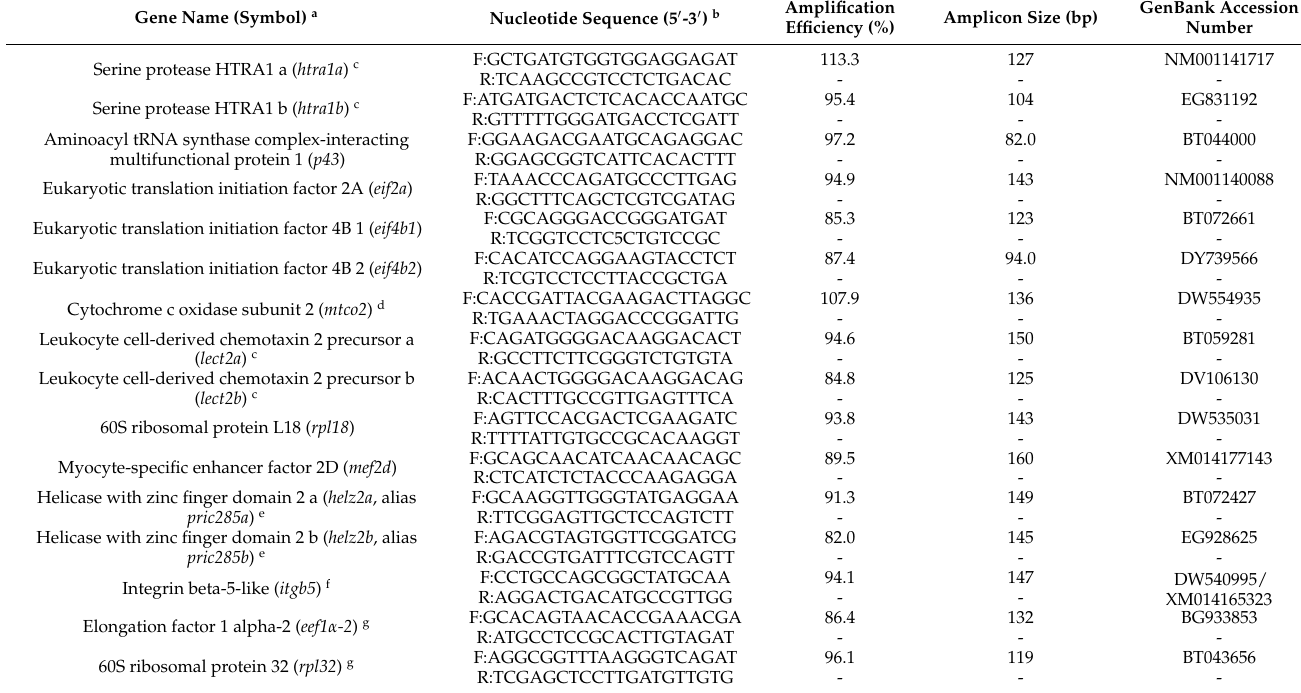
a Bolded gene symbols refer to microarray-identified transcripts. b F is forward and R is reverse primer. c Primers that were previously published in Caballero-Solares et al. [40]. d The Salmo salar sequence of mtco2 used in the qPCR assay showed 87% identity with the 60 mer microarray probe (C060R108) affiliated with rainbow trout ( Oncorhynchus mykiss ). e Primers that were previously published in Caballero-Solares et al. [15] (annotated as VHSV-induced protein in that study). Alias pric285 stands for peroxisomal proliferator-activated receptor A interacting complex 285. f The Atlantic salmon sequences of itgb5 used in the qPCR assay showed 86% identity with the 60mer microarray probe (C002R106) affiliated with rainbow trout. Primers were designed based on common regions between DW540995